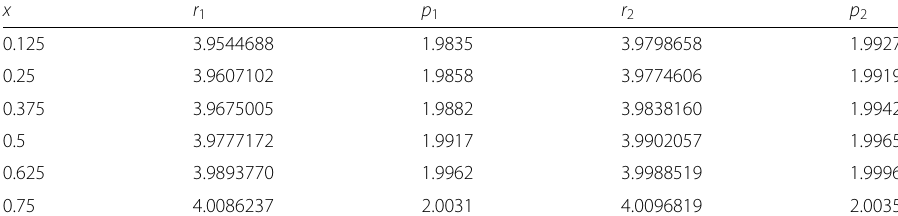
Table 5 The absolute error ratios at some grid points on t = 1 and the orders p 1 , p 2 for Example 3